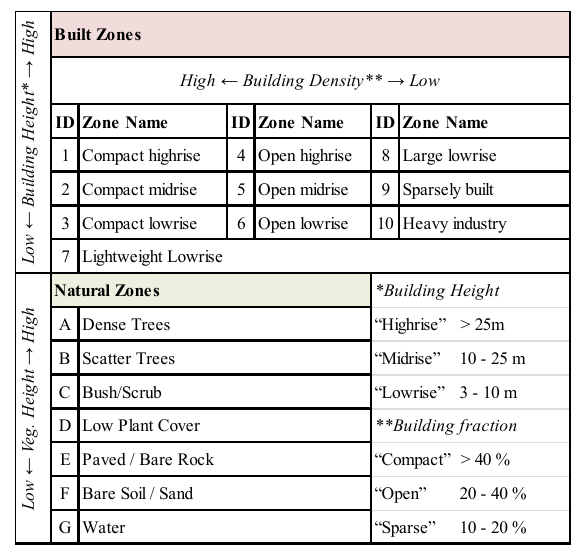
Table 2. Classes of the Local Climate Zones scheme.